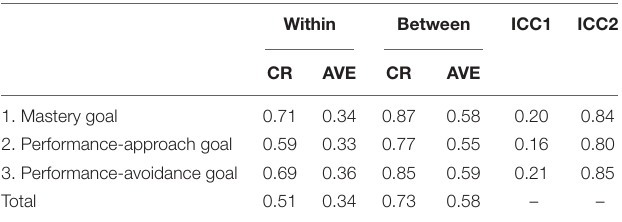
TABLE 4 | Composite reliability (CR), average variance extracted (AVE), and intraclass correlation (ICC) for multilevel confirmatory factor analysis (MCFA). Within Between ICC1